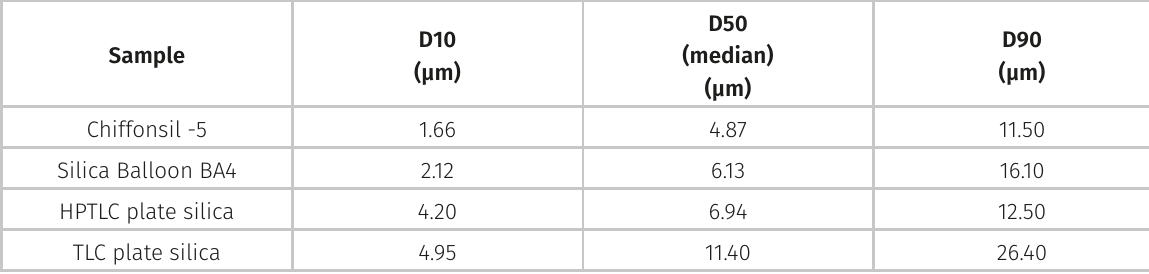
Table II. Granulometric analysis data for silica samples - Fraunhofer diffraction theory.